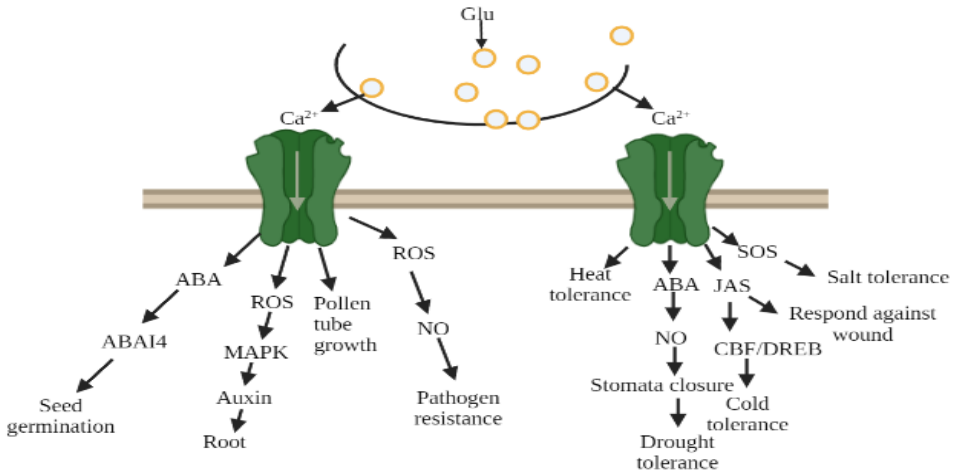
Figure 9. Glutamate receptors mediated by Ca 2+ ion due to environmental stress, glutamate (Glu), abscisic acid (ABA), reactive oxygen species (ROS), nitric oxide (NO), jasmonate (Jas).